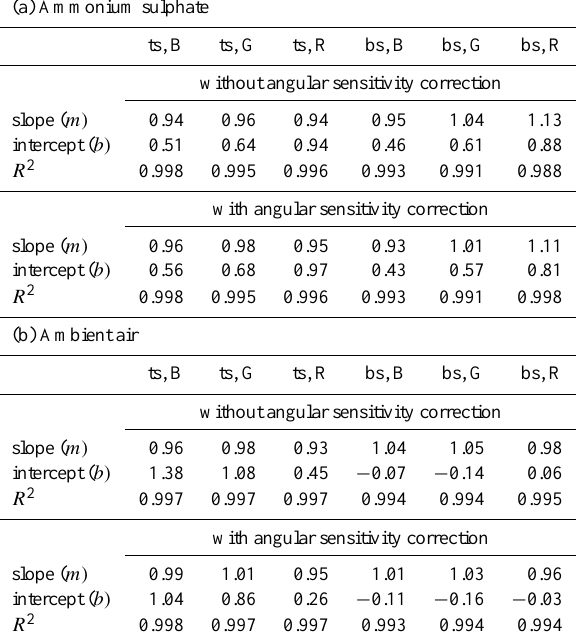
Table 4. Results of regression analysis ( σ Aurora3000 = m σ TSI3563 + b and the coefficient of determination R 2 ) of the Au- rora 3000 and TSI 3563 for total scattering (ts) and backscattering (bs). The intercept b is given in units of Mm − 1 . Directly measured values as well as angular sensitivity corrected values are shown. Wavelengths are B=450nm, G=525nm, and R=635nm. Values are given for (a) ammonium sulphate and (b) ambient